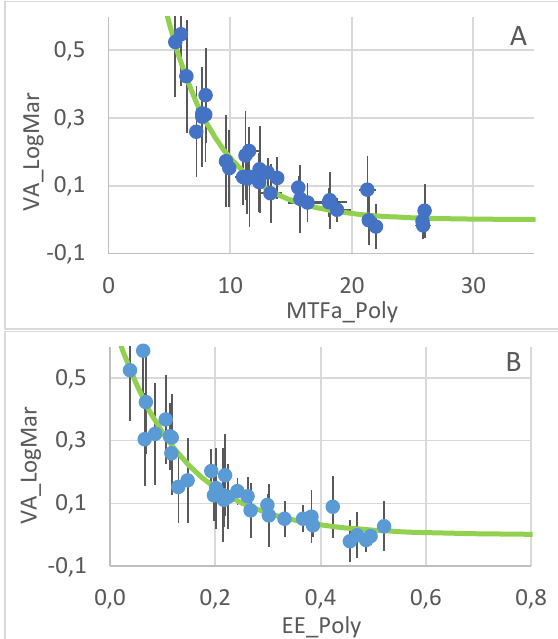
Fig. 1. Monochromatic R, G and B MTFa (A) and EE (B) versus defocus (at spectacle plane) obtained with 3mm pupil for the FineVision MIOL. Polychromatic functions in black.